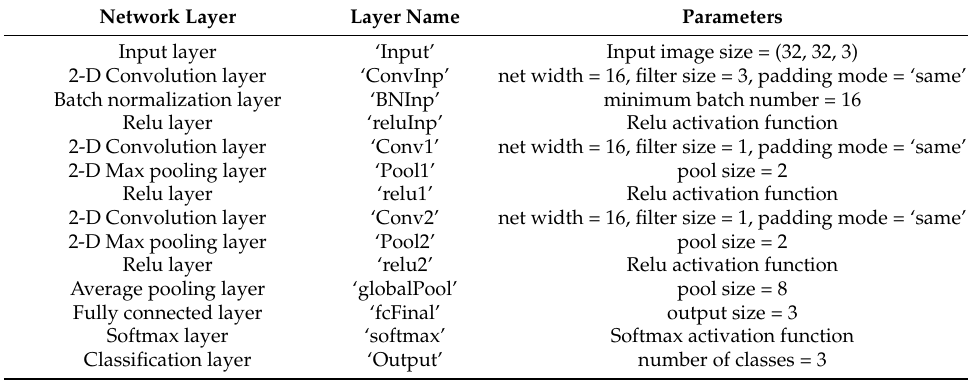
Table 2. The layer settings of the proposed